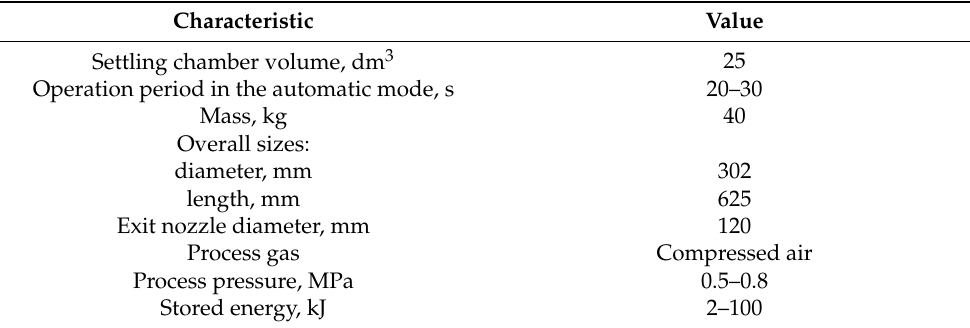
Table 1. Basic engineering characteristics of AIG ‐ 25/8.